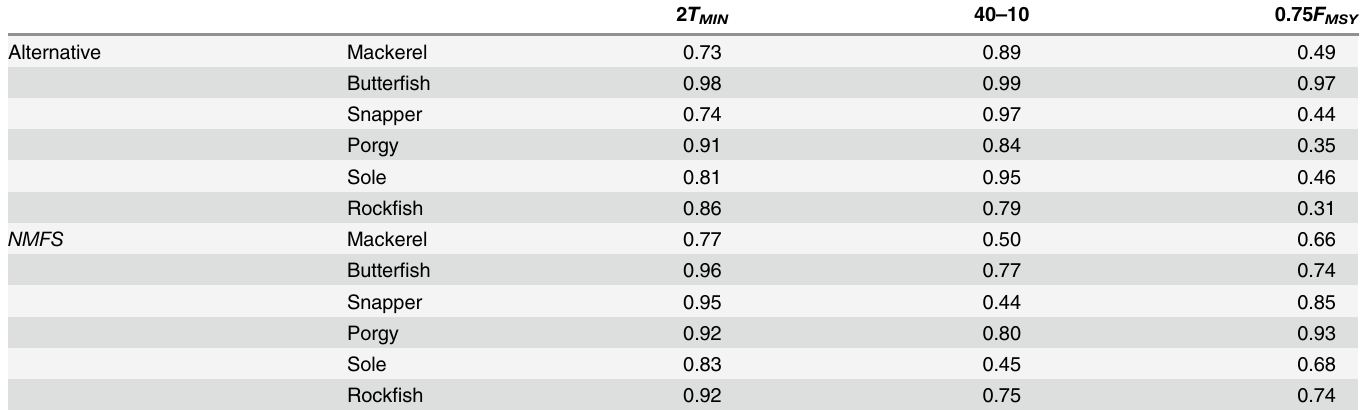
Table 2. Proportion of simulations in which (i) the three alternative MPs achieved as fast or faster rebuilding times than the NMFS MP (Perfor- mance indicator 1, top); and (ii) the NMFS MP achieved as fast or faster rebuilding times than the alternative MPs (Performance indicator 2, bottom) for the starting depletion sensitivity